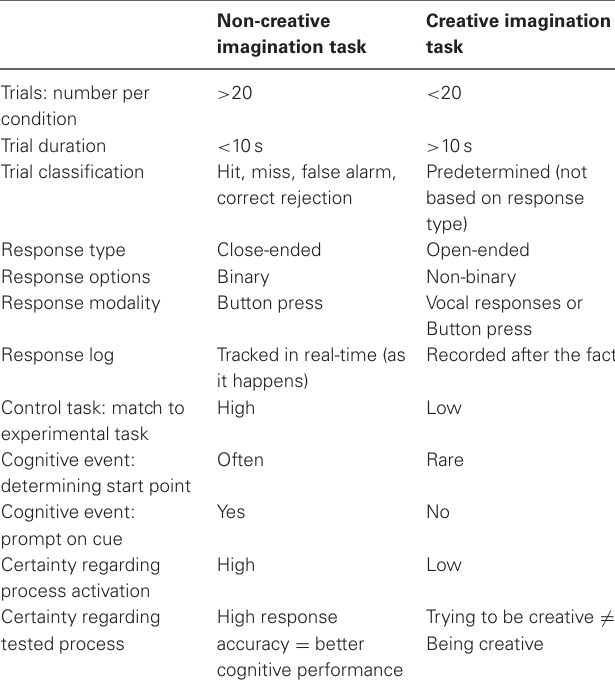
Table 1 | A generalized comparison of common methodological and conceptual differences between creative and non-creative